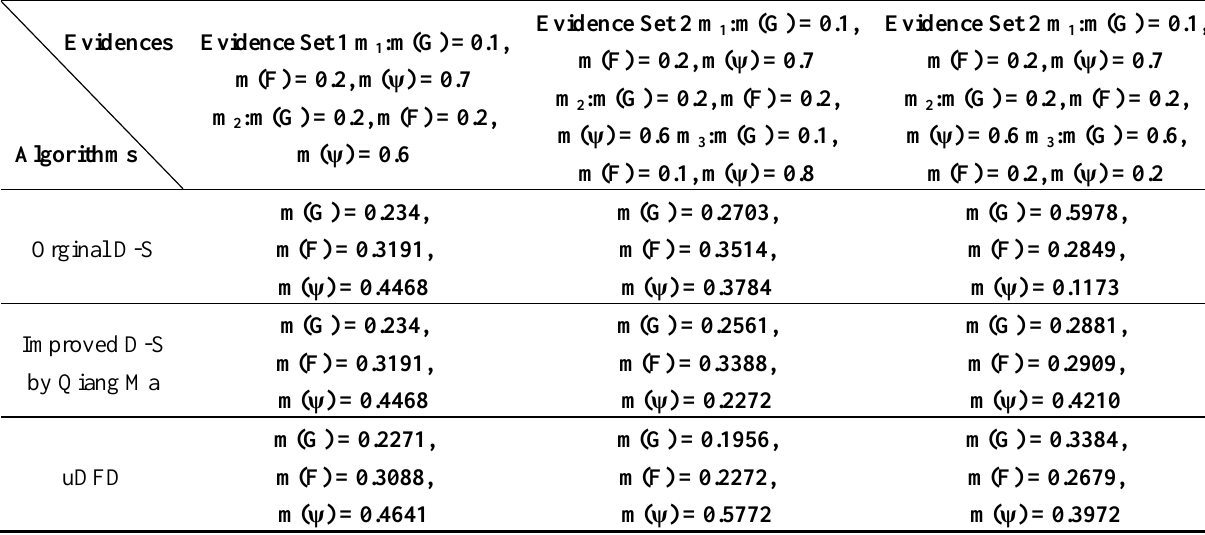
Table 1. Results of evidence fusion.